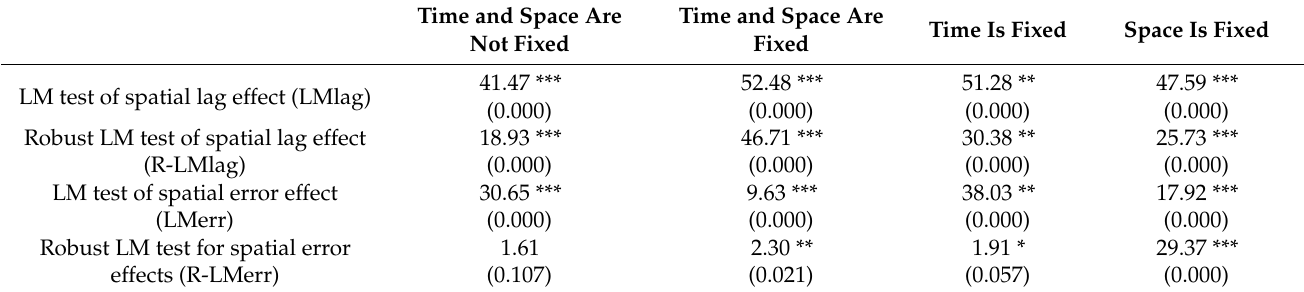
Table 4. LM testing